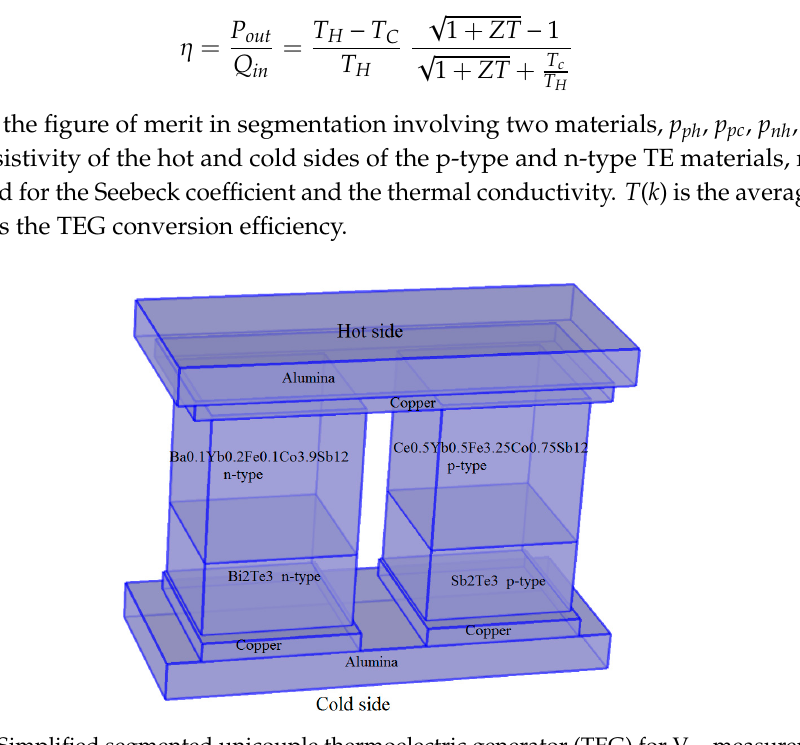
Figure 2. Simplified segmented unicouple thermoelectric generator (TEG) for V oc measurement.